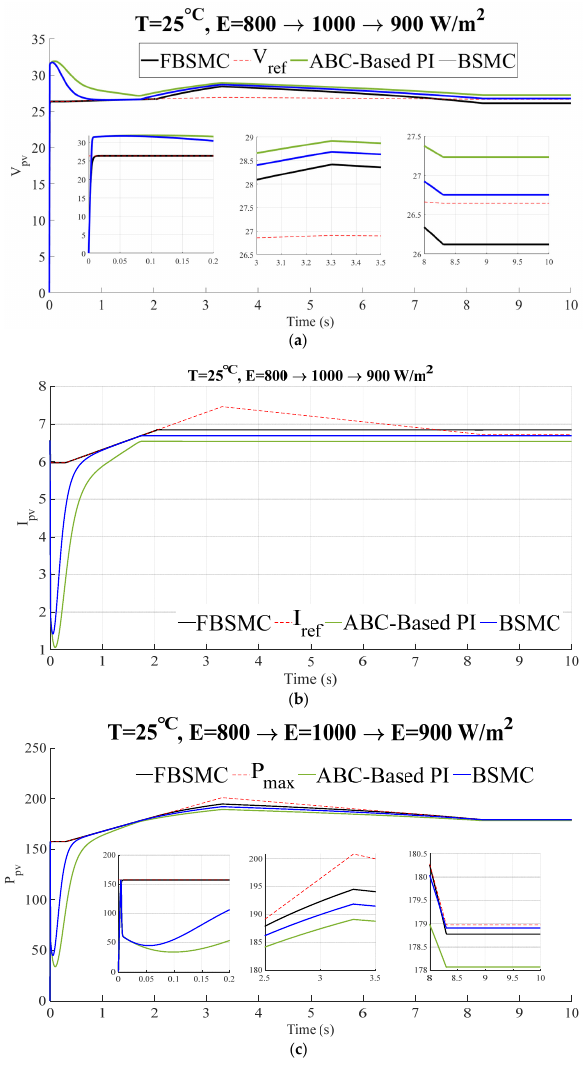
Figure 9. ( a ) Voltage ( b ) current, ( c ) power of the controlled PV (Scenario 5).